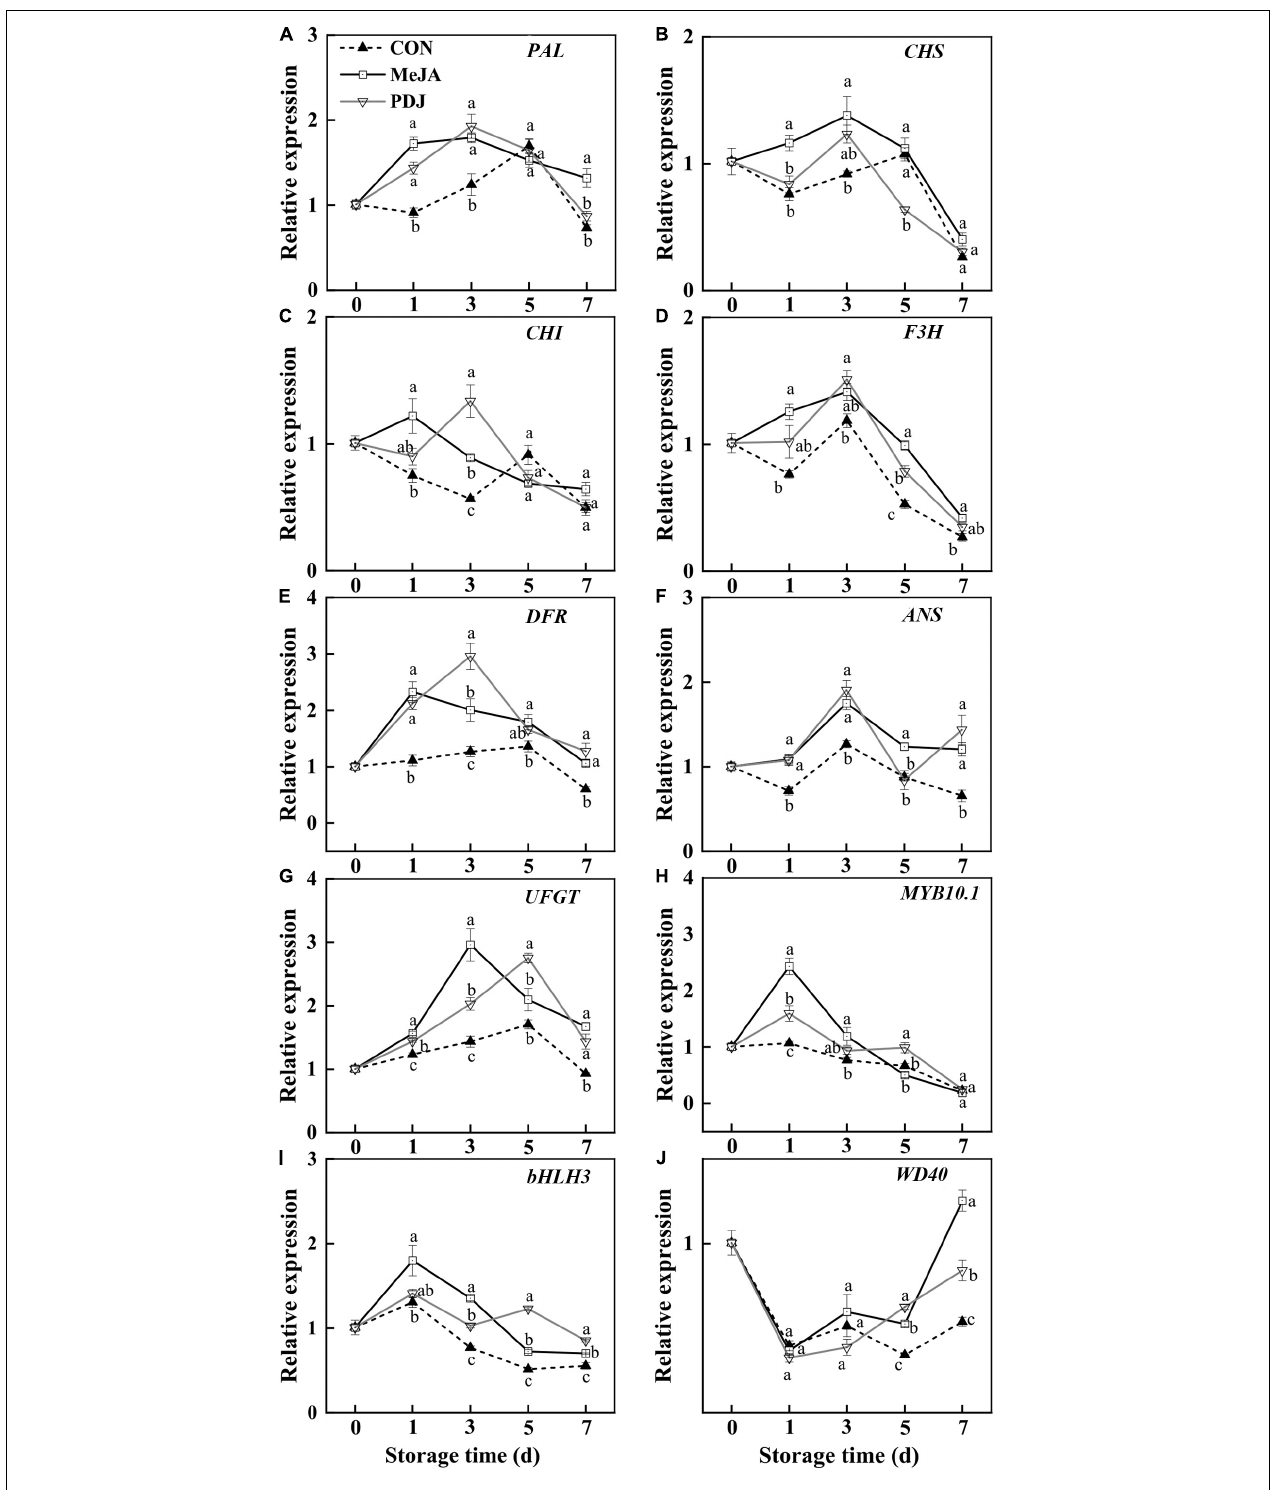
FIGURE 5 | Effects of postharvest jasmonate treatments on the expressions of genes associated with anthocyanins biosynthesis during storage (22 ± 2 ◦ C; light intensity 300–400 lux; different lower-case letters indicate significant differences ( P < 0.05) from three treatments at the same time point). (A–J) PAL, CHS, CHI, F3H, DFR, ANS, UFGT, MYB10.1, bHLH3, WD40.